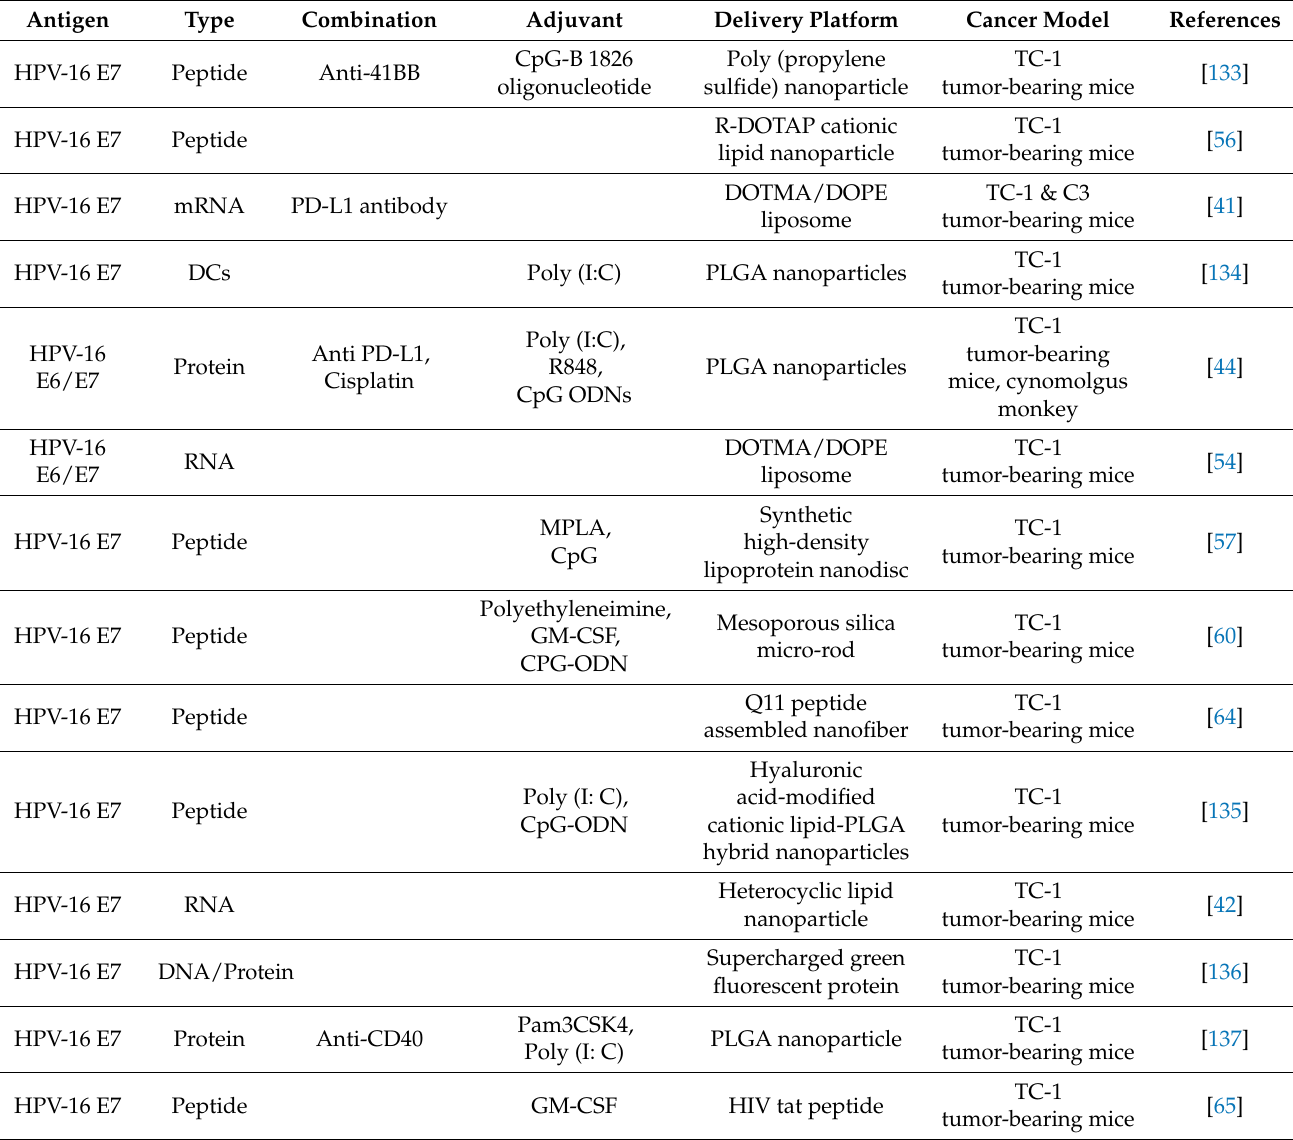
Table 2. Nanovaccine preclinical studies for HPV-related